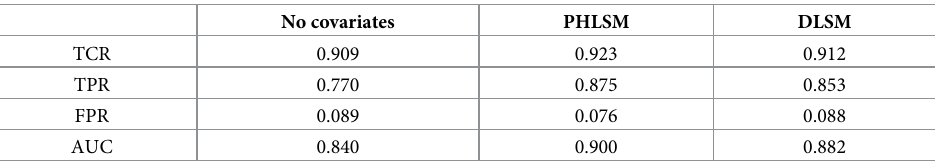
Table 6. Predictive results for the Pokec